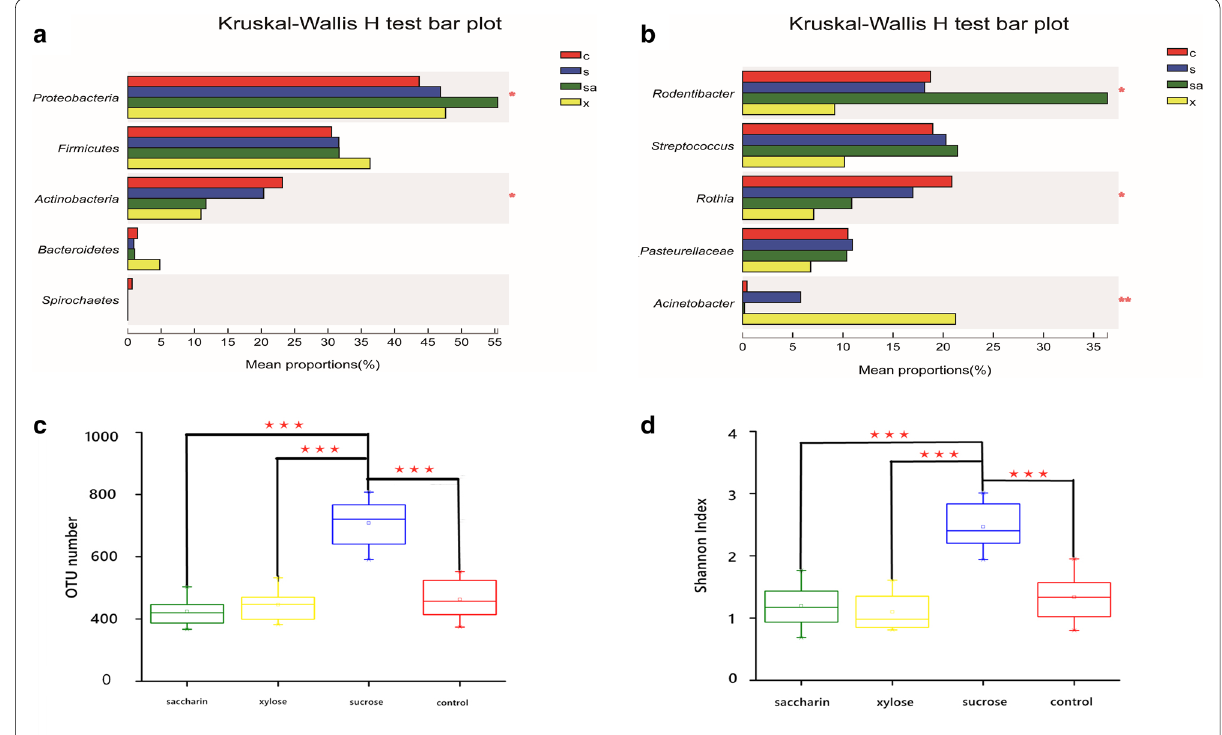
Fig. 2 Statistical comparison of the relative abundance ( a , b ) and alpha diversities ( c , d ) of the oral microbiota observed in each of the four groups of rats. a Comparison of dominant phyla in the control (c group), xylose (x group), sucrose (s group), and saccharin (sa group) groups. b Comparison of the dominant genera in the control (c group), xylose (x group), sucrose (s group), and saccharin (sa group) groups. c Bacterial community richness in each of the four groups. d Bacterial community diversity in each of the four groups. p < 0.05 was considered significant. * 0.01 <